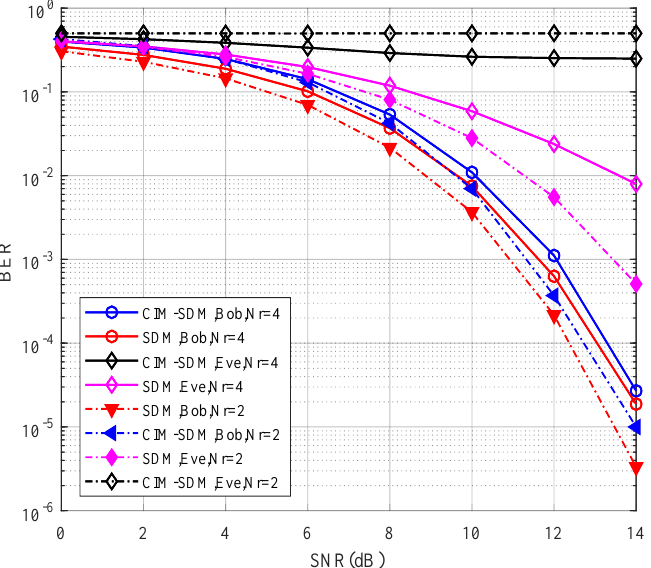
Figure 11. Bob’s and Eve’s receiver index error rate performances for the proposed CIM-SDM scheme in comparison to the traditional SDM